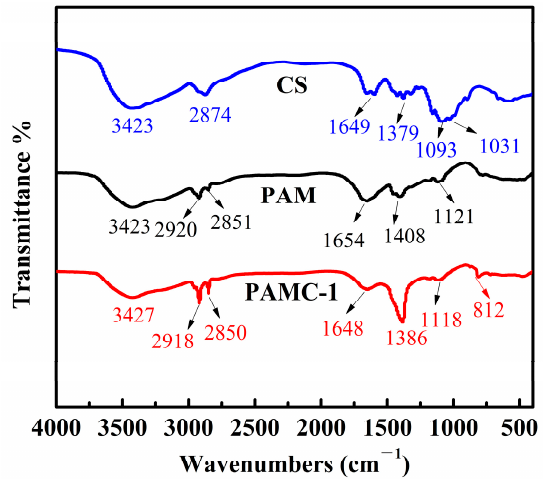
Figure 2. FTIR spectra of PAMC, PAM, and CS.